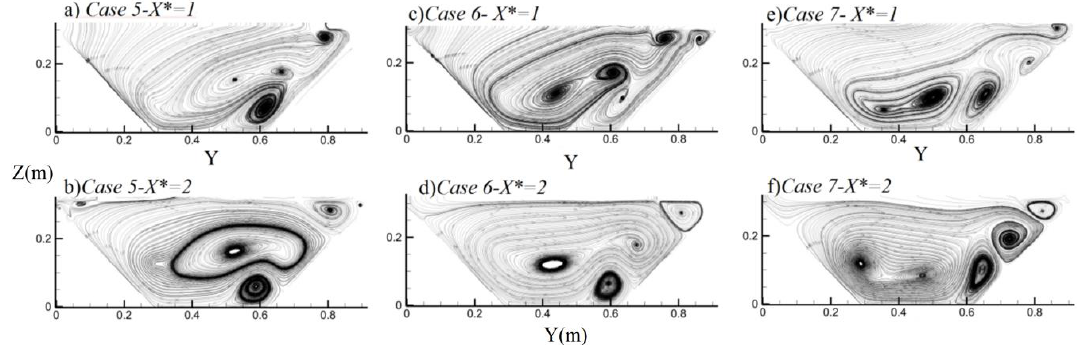
Figure 13. The effect of variations in W* and q* on flow patterns in the transverse plane in the trapezoidal channel.